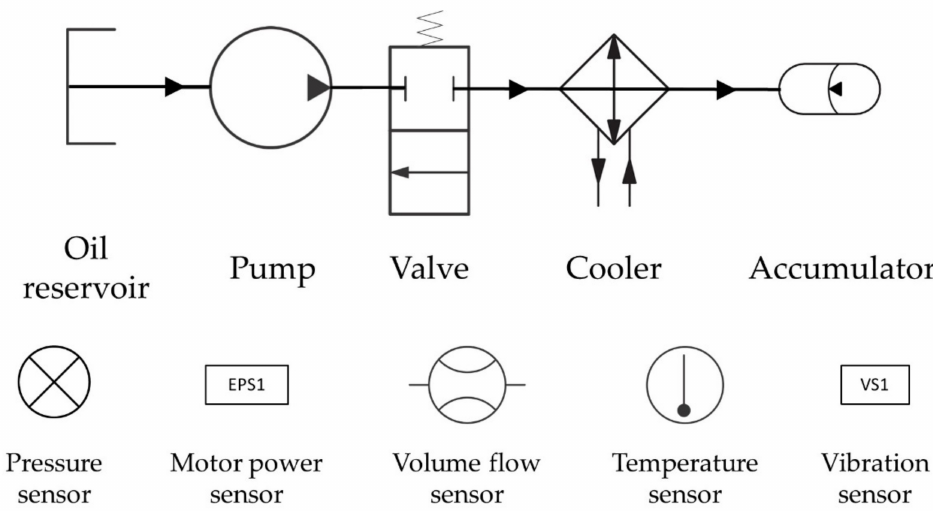
Figure 1. Concise hydraulic system circuit and installed sensors.